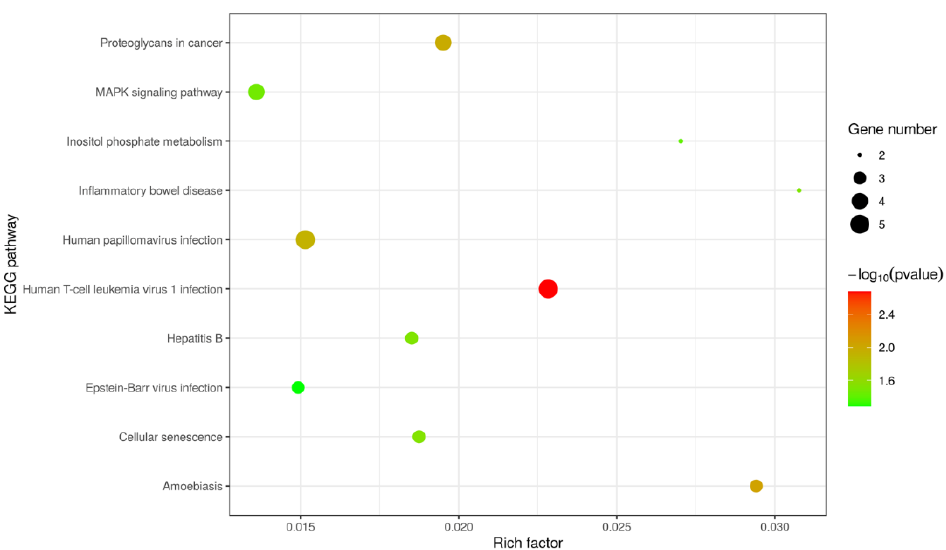
Figure 7. Bubble map of the enriched KEGG pathways of DEP in SW1990 cells treatment with G-6 10 µM for 24 h. The top 10 result pathways with KEGG enrichment were shown in the bubble map and bubble diagram of differential proteins enriched in various pathways. Bubble diameters represent the number of proteins in each pathway. The color represents the magnitude of significance of enrichment.